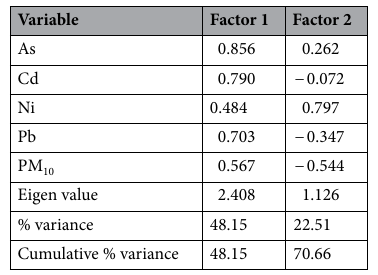
Table 3. Extraction method: Principal Component Analysis.